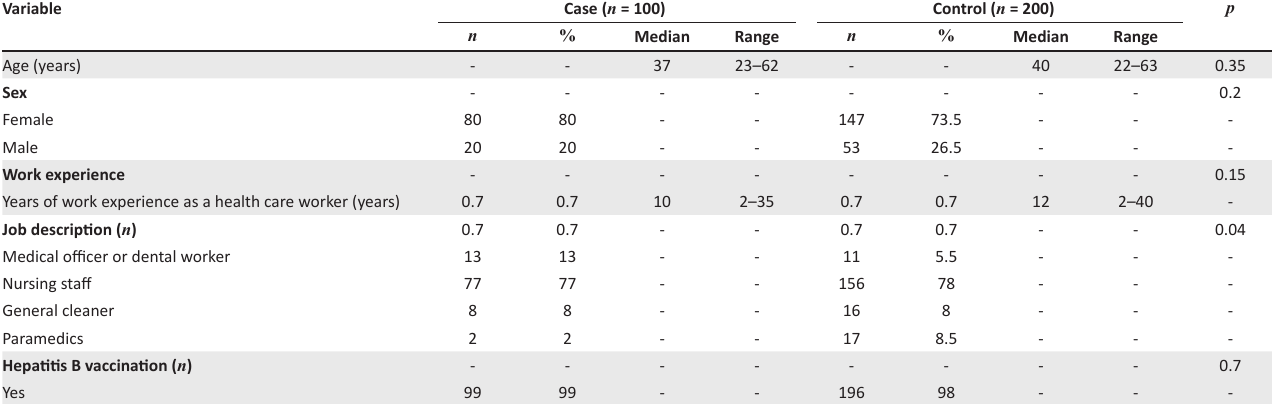
TABLE 1: Demographic characteristics of health care workers (cases and controls) surveyed for knowledge and practice of universal precautions ( N = 300). Variable